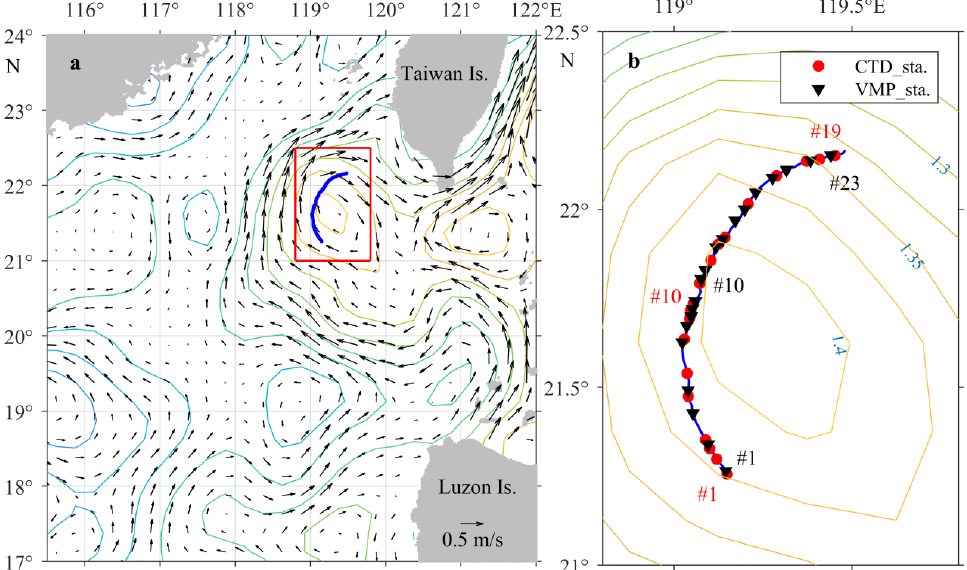
Figure 1. The study region, surface geostrophic current and the sampling stations during the field observations. ( a ) The surface geostrophic currents (arrows) and the corresponding absolute dynamic topography (colored contours, with a contour interval of 0.05 m) from Archiving, Validation, and Interpretation of Satellite Oceanographic data (AVISO). The blue curve indicates the R/V track. ( b ) The sampled CTD (red dots, #1 − #19) and VMP stations (black triangles, #1 − #23) shown in a zoomed area indicated by the red rectangle in ( a ). Colored contours are the same as in ( a ).